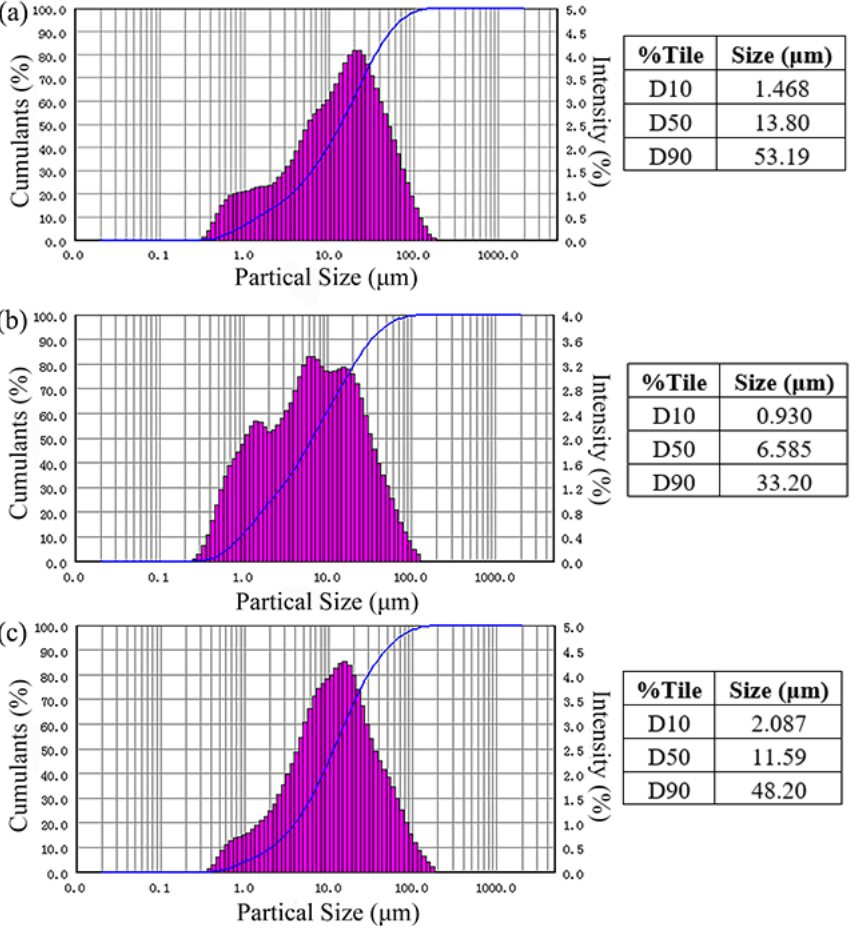
Figure 7. Particle size distribution histograms and cumulative particle size distribution (D10, D50, and D90) of ( a ) ore sample, ( b ) carbon-free sample, and ( c ) quartz-free and D90) of ( a ) ore sample, ( b ) carbon-free sample, and ( c ) quartz-free sample. Table 2. Particle size distributions of ore, carbon-free, and quartz-free samples.